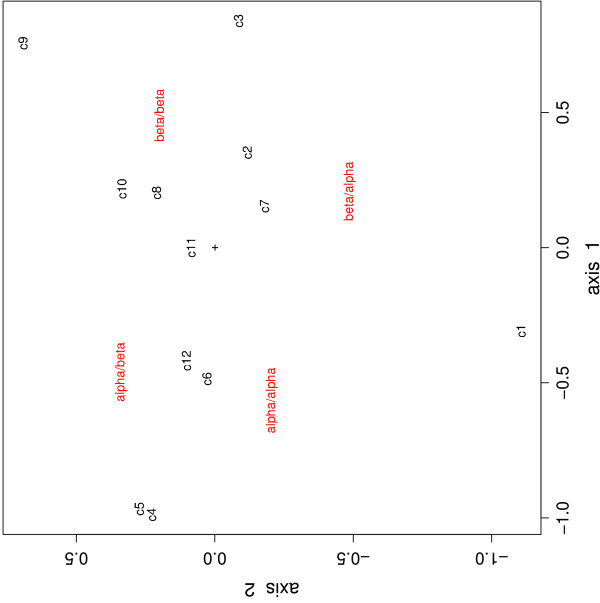
Principal component analysis of the association between hidden states and loop type. Data are obtained from the Viterbi decoding using secondary structure labeling on the cross-validation data.